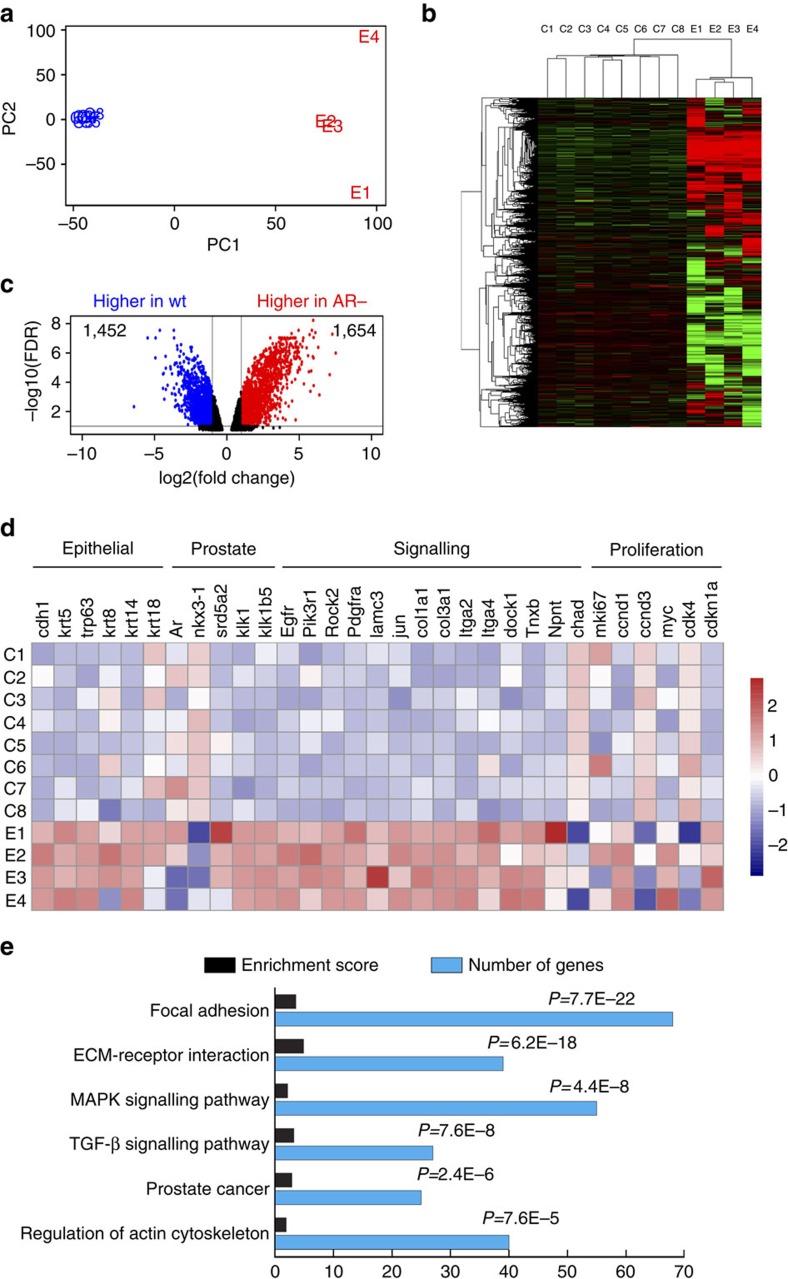
Gene expression profiling analyses of AR−
luminal cells.(a) Scatter-plot of the two main components from a Principal Component Analysis of control (wild-type, blue points) and experimental (AR−, red points) luminal samples based on 9,238 genes after filtering out too lowly or too highly expressed genes, capturing 44.5% (dimension 1) and 16.6% (dimension 2) of the data variability. (b) Unsupervised hierarchical clustering analysis showing good separation of control samples (C1–C8) and AR− luminal samples (E1–E4). (c) Volcano plot showing 1,654 genes are upregulated and 1,452 genes are downregulated in AR− luminal cells (FDR<0.1 and fold change >2). (d) Expression levels of selected genes in different samples showing a general upregulation of epithelial markers and various cell signalling genes in AR− luminal cells, and mixed expression pattern changes for proliferation markers. (e) DAVID GO analysis showing the most enriched pathways in AR− luminal cells (FDR<0.1) and the number of genes in each pathway.